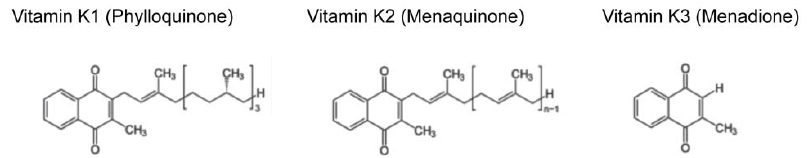
Figure 1. Molecular structures of the three forms of vitamin K. Vitamin K1, K2, and K3 share naphthoquinone ring, but differ in their side chains. Vitamin K1 has a phytyl side chain. Vitamin K2 has a side chain with varying number of isoprene units and called “MK-n” depending on the number of isoprene units. Vitamin K3 is a synthetic vitamin K without a side chain.